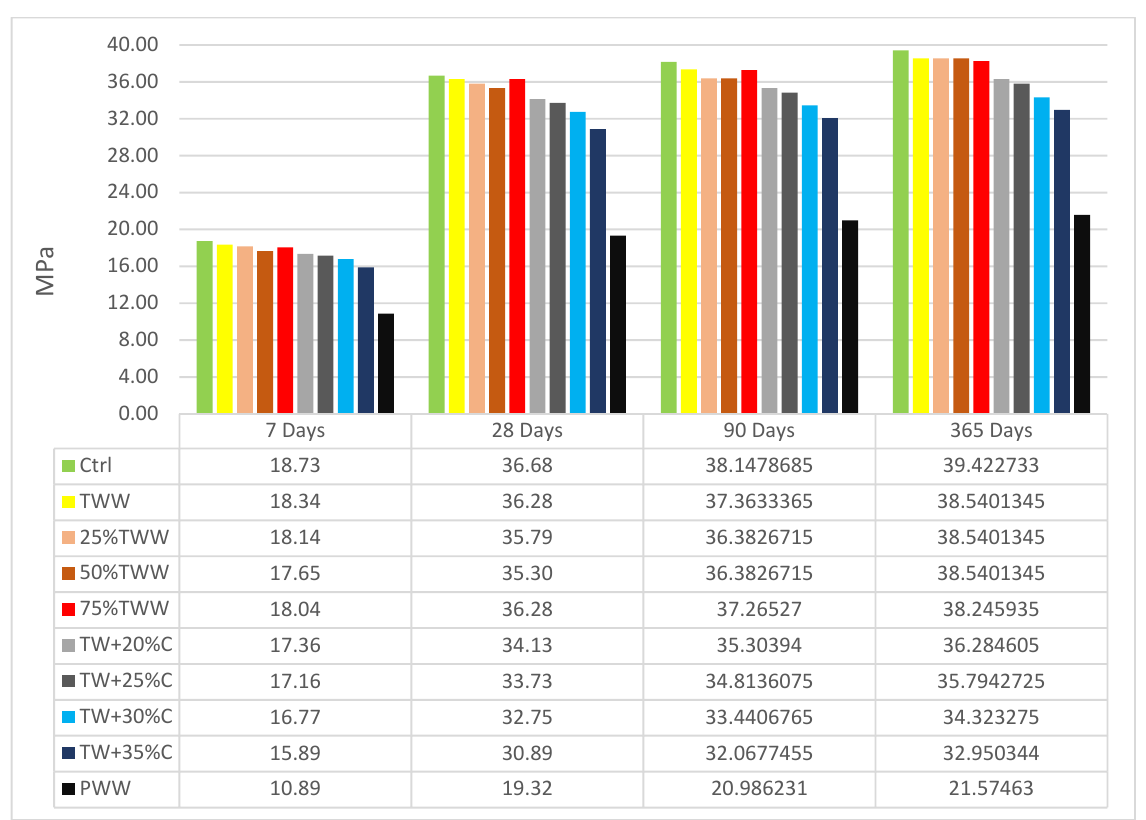
Figure 4. Compressive strength cured by treated wastewater.